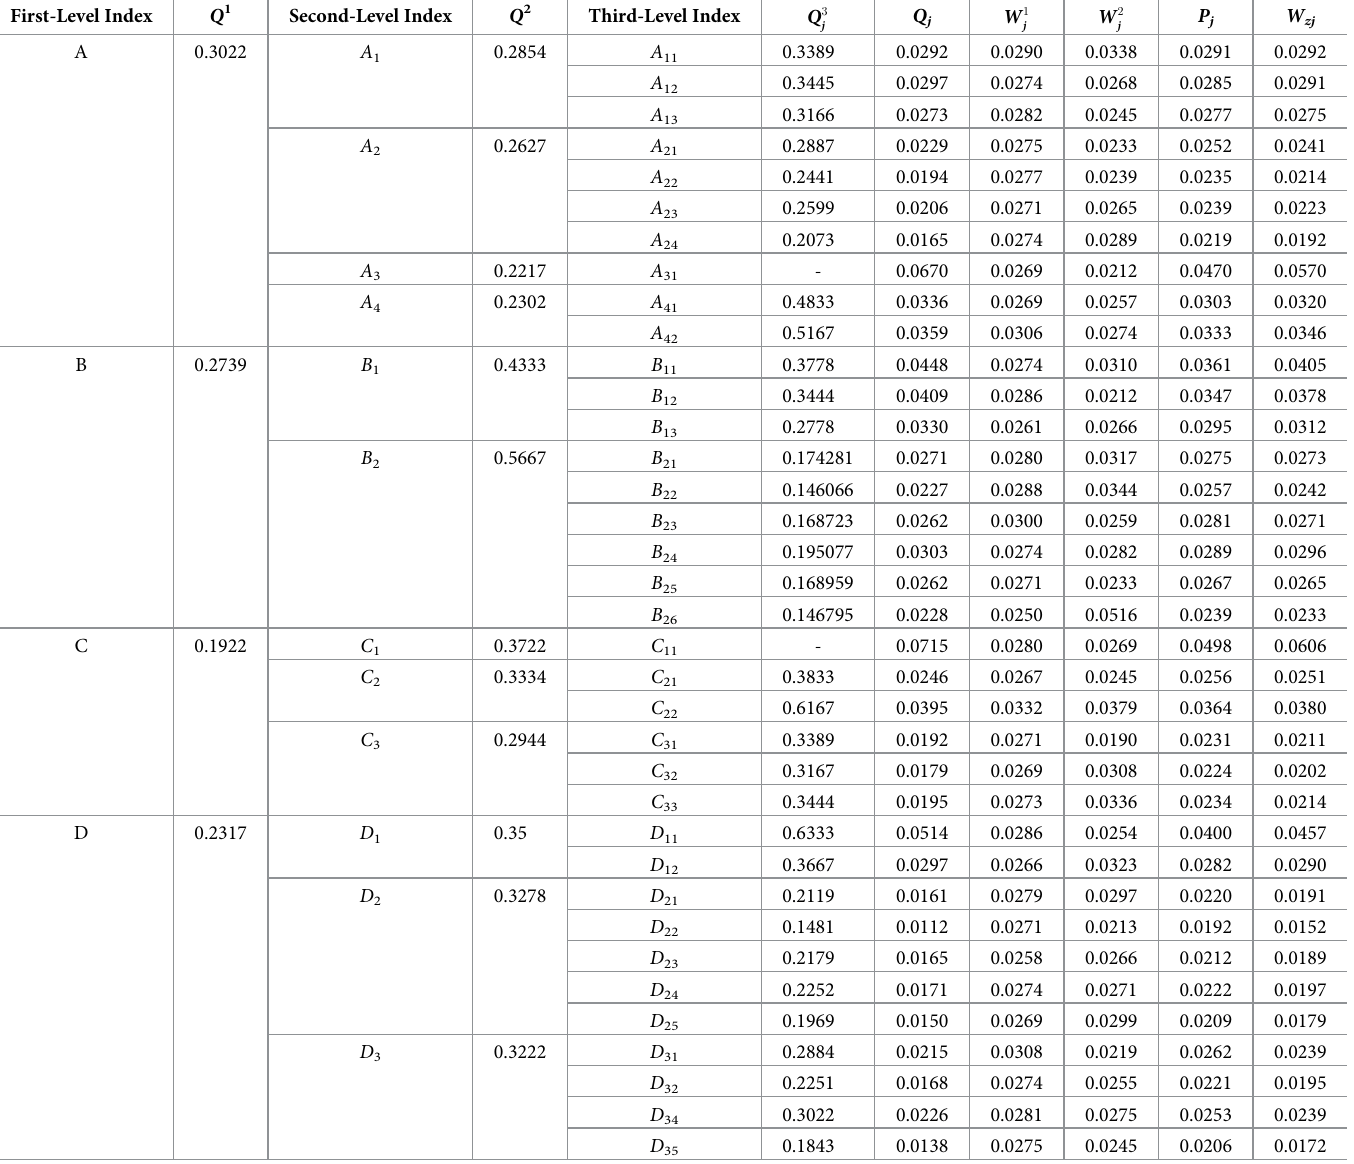
Table 8. Index weight of digital economy index